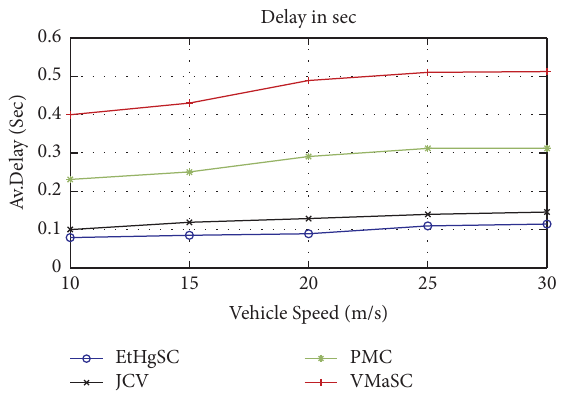
Figure 12: Average delay at diferent